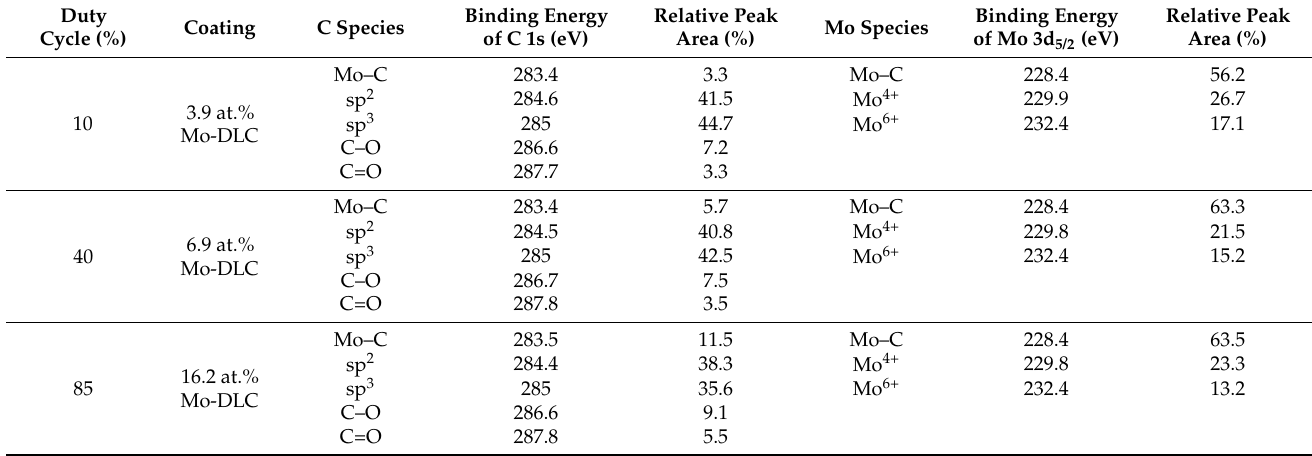
Table 1. Binding energies and relative peak areas of carbon and molybdenum species in Mo-DLC coatings deposited with different duty cycles.